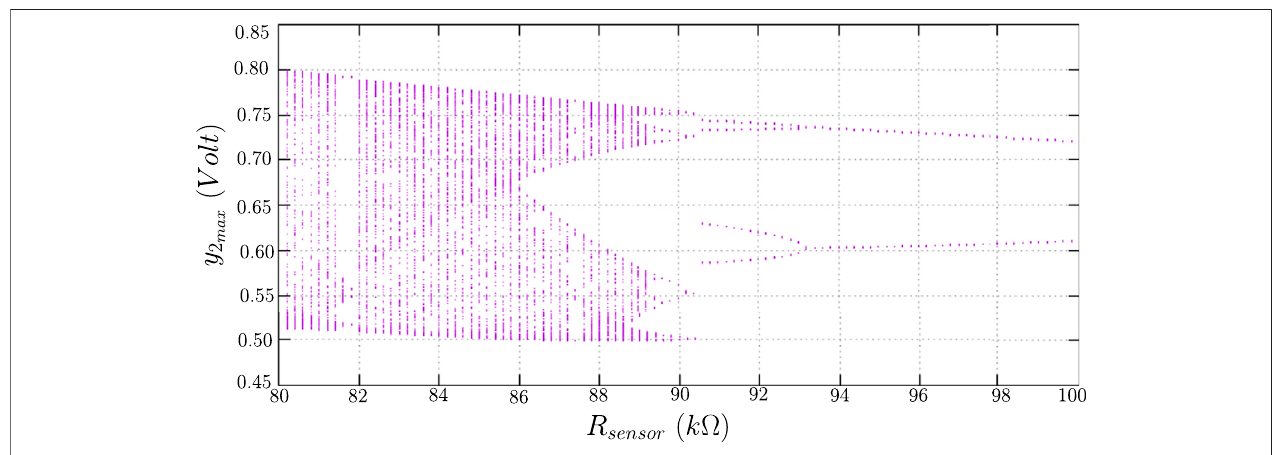
FIGURE 3 | Experimental bifurcation diagram of the coupled van der Pol and damped Duf fi ng circuit.